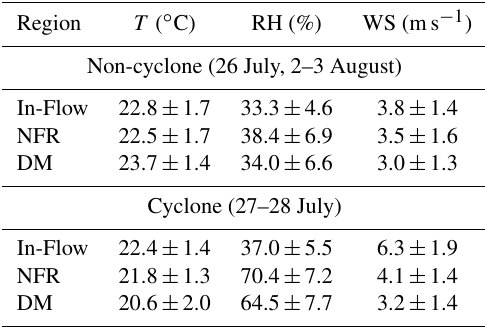
Table 1. Average temperature ( T , ◦ C), relative humidity (RH, %), and wind speed (WS, ms − 1 ) for measurements separated into In- Flow, NFR, and DM regions during the non-cyclone and cyclone episodes.